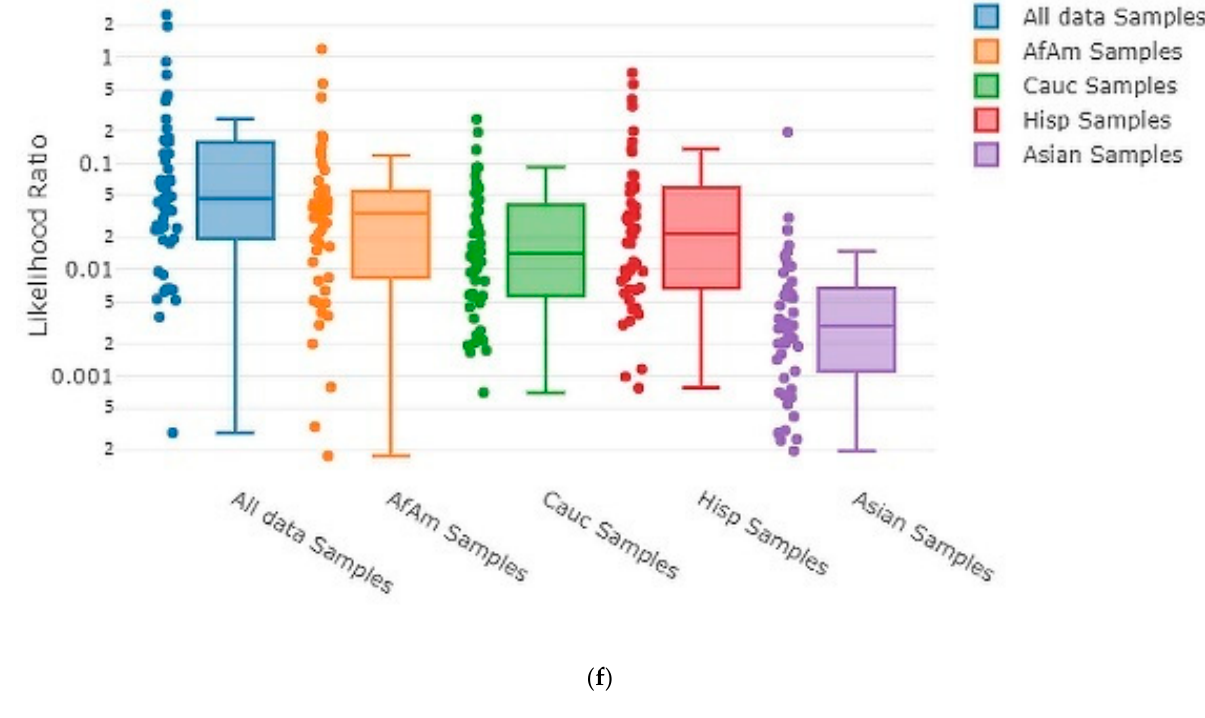
Figure 3. MaSTR™-generated random database in silico contributor genotype LR plots. MaSTR™ synthesized 100 random genotypes using allele frequency data from the four groups shown, as well as 100 additional genotypes synthesized from a combination of the four to yield 500 random genotypes for testing with each analysis run performed. The mixture ratios and template quantities shown are ( a ) three-person 1:3:5 (~100:300:500 pg), ( b ) three-person 1:3:5 (~13:38:63 pg), ( c ) four-